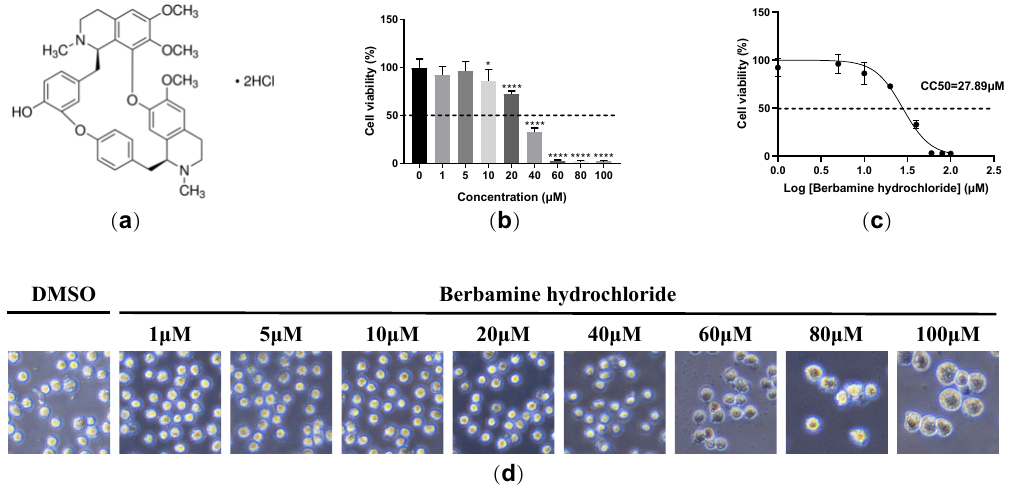
Figure 1. The cytotoxicity of berbamine hydrochloride in PAMs. ( a ) The chemical structure of berbamine hydrochloride; ( b ) the cell viability of berbamine hydrochloride in PAMs was